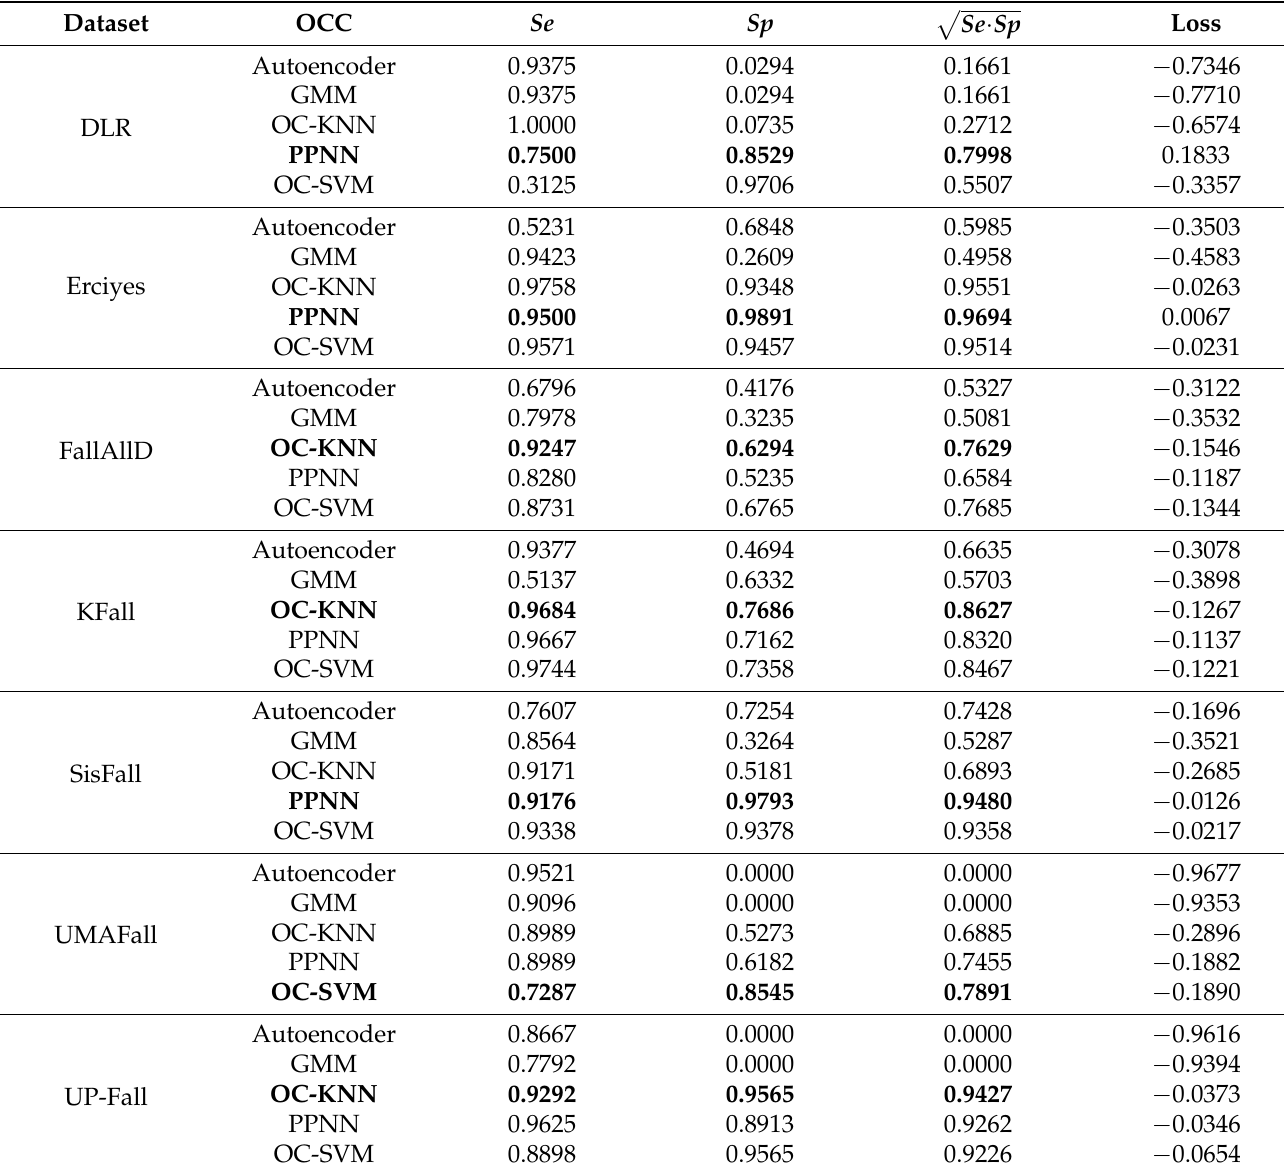
Table 13. Results of the classifiers when they are tested with falls and sporting activities and trained with the rest of ADL categories (results for the IMUFD dataset are not included, as this repository does not include sporting